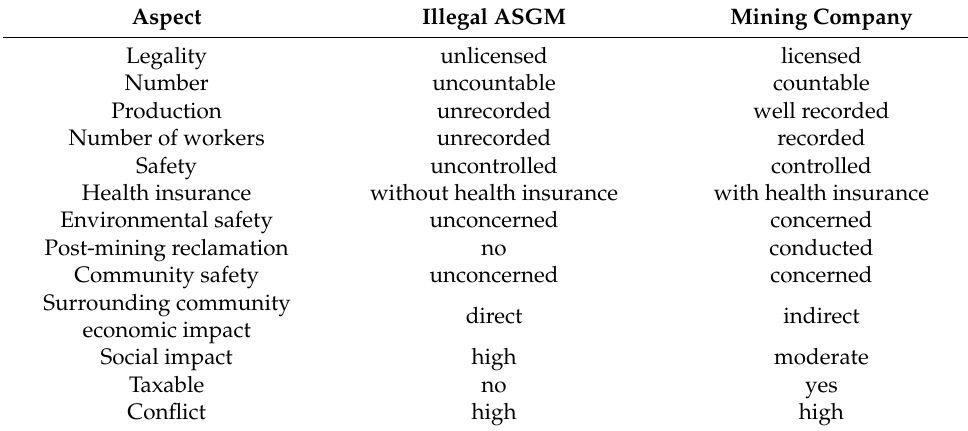
Table 7. Comparison between illegal ASGM and mining companies in Indonesia. Aspect Illegal ASGM Mining Company Legality unlicensed